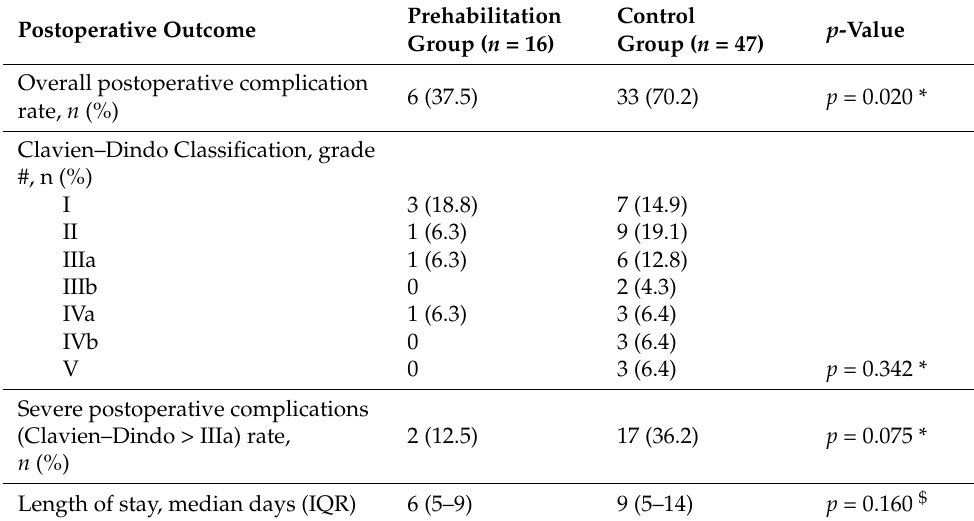
Table 3. Secondary